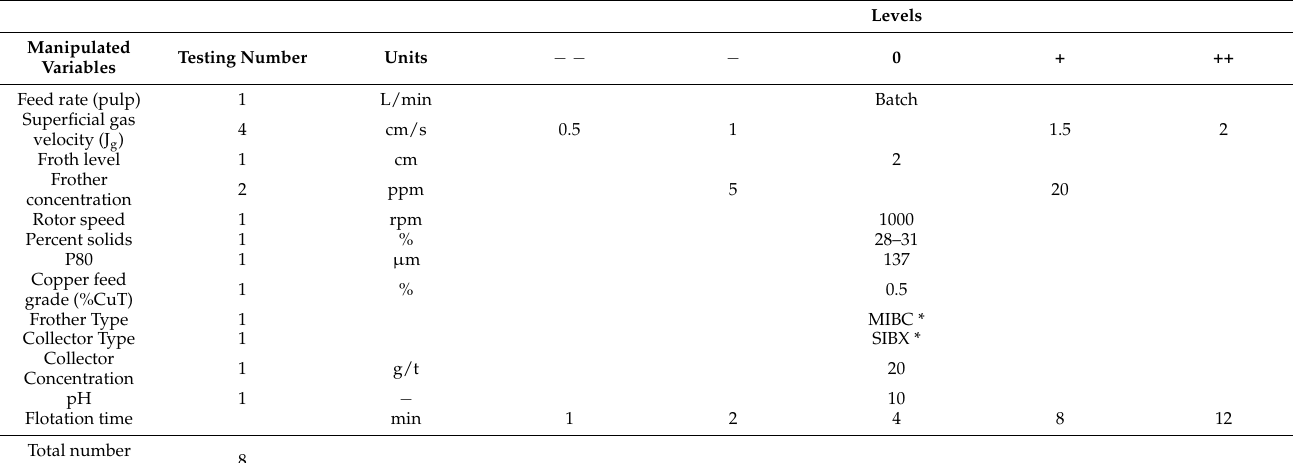
Table 3. Experimental conditions for metallurgical performance